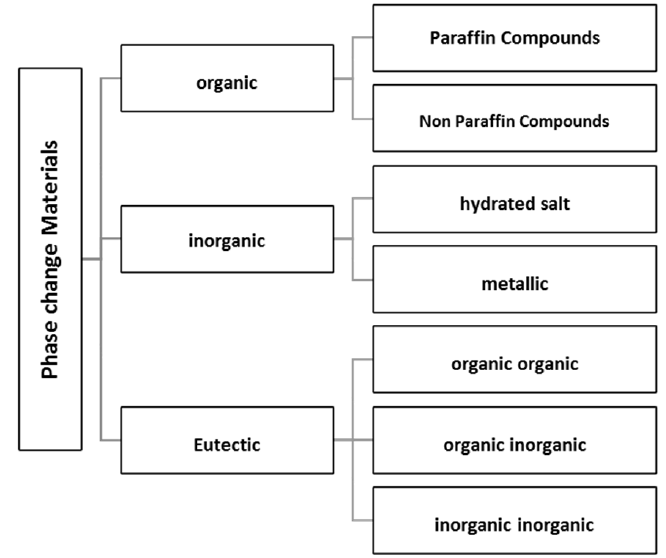
Figure 5. Diagram of PCM classification [17].